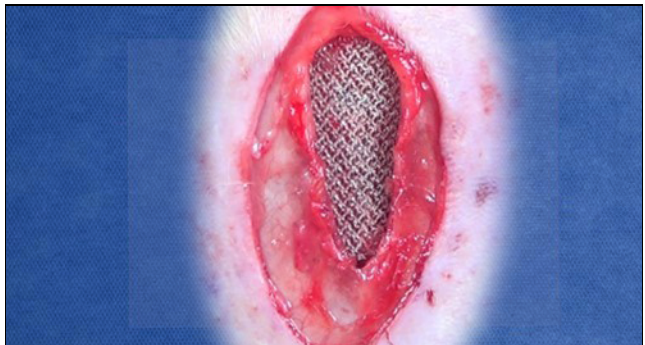
Figure 2 - Manual placement of the 3.5 × 2.5 cm polypropylene mesh directly under the rectus abdominis muscle.